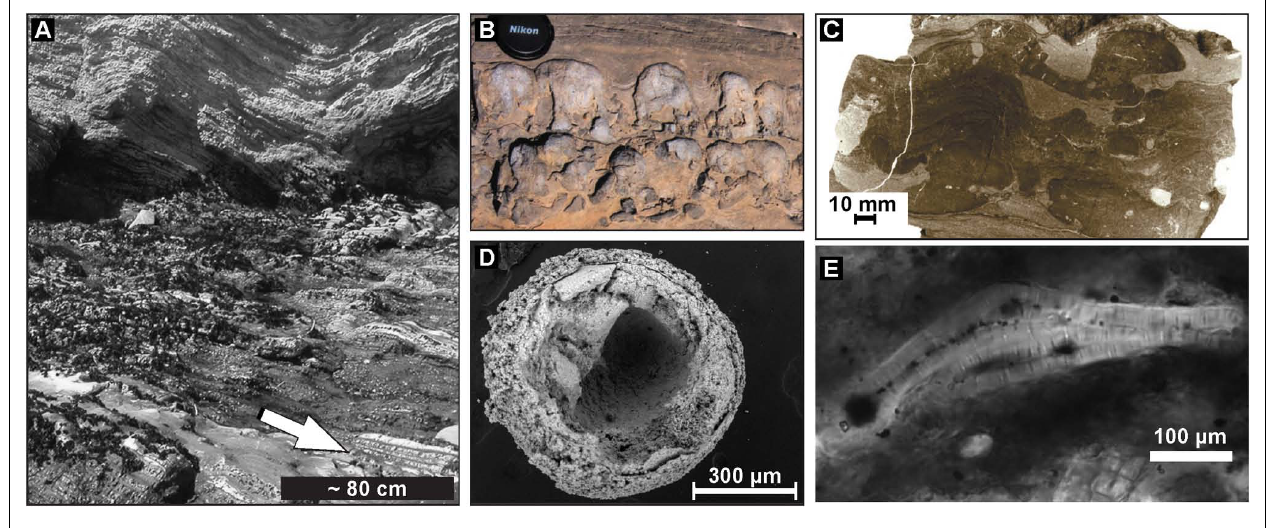
FIGURE 2 | (A) Phosphorites (arrow) overlain by diatomites from the Miocene Monterey Formation at Shell Beach, California, preserve filaments in (E) . (B) Phosphatic microbialite in condensed horizon developed in OC-rich sandy mudstone horizon.Winnowed phosphate nodules are incorporated in the microbialite. (C) Intergrowth of columnar and flat-laminated phosphatic structures developed as a result of microbial mat growth and sediment